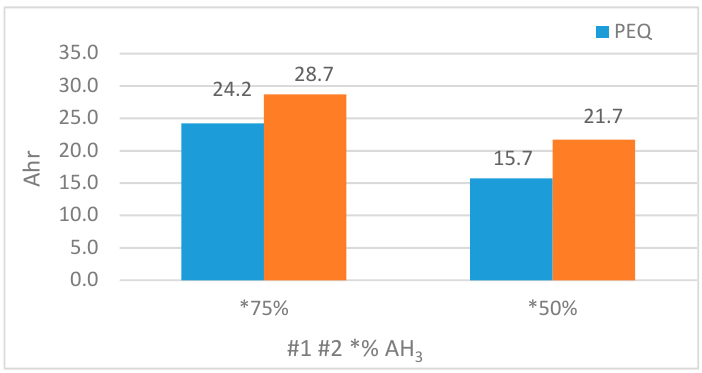
Figure 9. Batteries 2019 , 5 , x